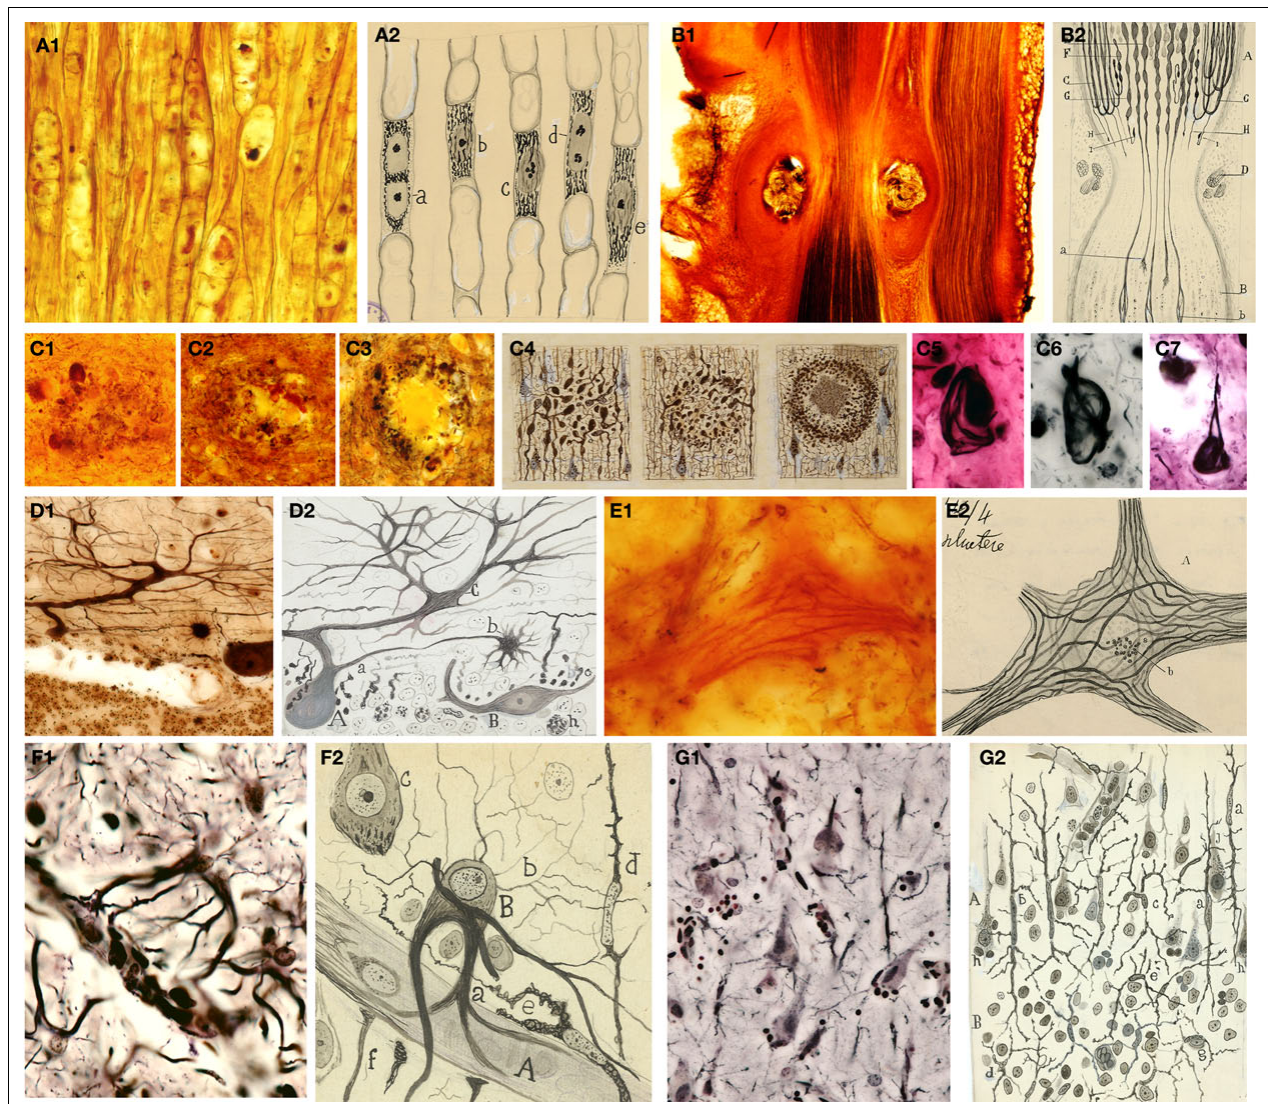
FIGURE 5 | Cajal’s histological preparations and drawings showing some contributions to the pathology of the Nervous System. (A) Degeneration of nerve fi bers (reduced silver nitrate); (B) Experiment of ligadura in the peripheral nervous system (reduced silver nitrate); (C) Senile plaques and neurofi brillary tangles in Alzheimer´s disease (reduced silver nitrate and ammoniacal silver oxide); (D) “dementia praecox” in Purkinje cell with